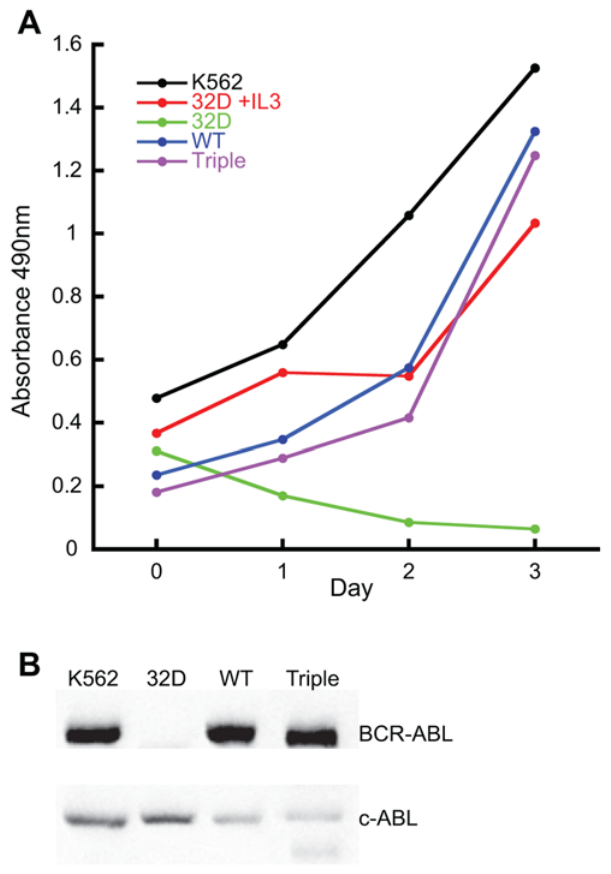
Figure 1. The triple mutant of BCR-ABL is capable of inducing growth factor independence. 32D cell lines matched for BCR-ABL expression were analyzed for their requirement of interleukin-3 (IL-3) for growth. (A) Representative graph of cell proliferation assay on 32D cell lines matched for expression of BCR-ABL grown in the absence of IL-3. (B) Western blot of BCR-ABL (upper panel) and ABL (lower panel) showing relative expression levels of cell lines shown in A.